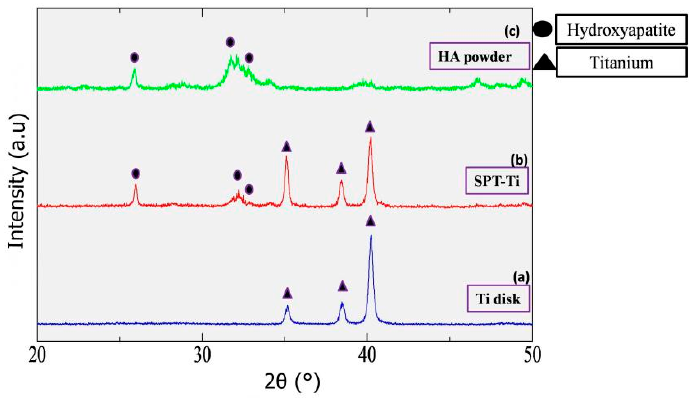
Figure 5. X-ray diffractogram obtained from ( a ) Polished-Ti, ( b ) Ti-AT-SPT, and ( c ) synthetic HA Figure 5. X ‐ ray diffractogram obtained from ( a ) Polished ‐ Ti, ( b ) Ti ‐ AT ‐ SPT, and ( c ) synthetic HA powder. All the diffraction peaks obtained from Ti-SPT were assigned to HA or the titanium substrate powder. All the diffraction peaks obtained from Ti ‐ SPT were assigned to HA or the titanium substrate under the deposited under the deposited film.